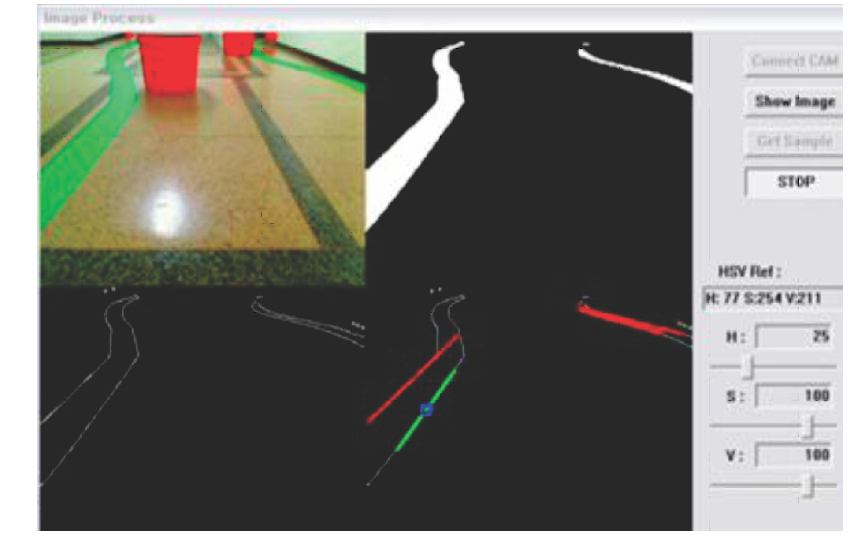
FIG. 24. COMPUTER SIMULATION WINDOW OF VISION CAMERA